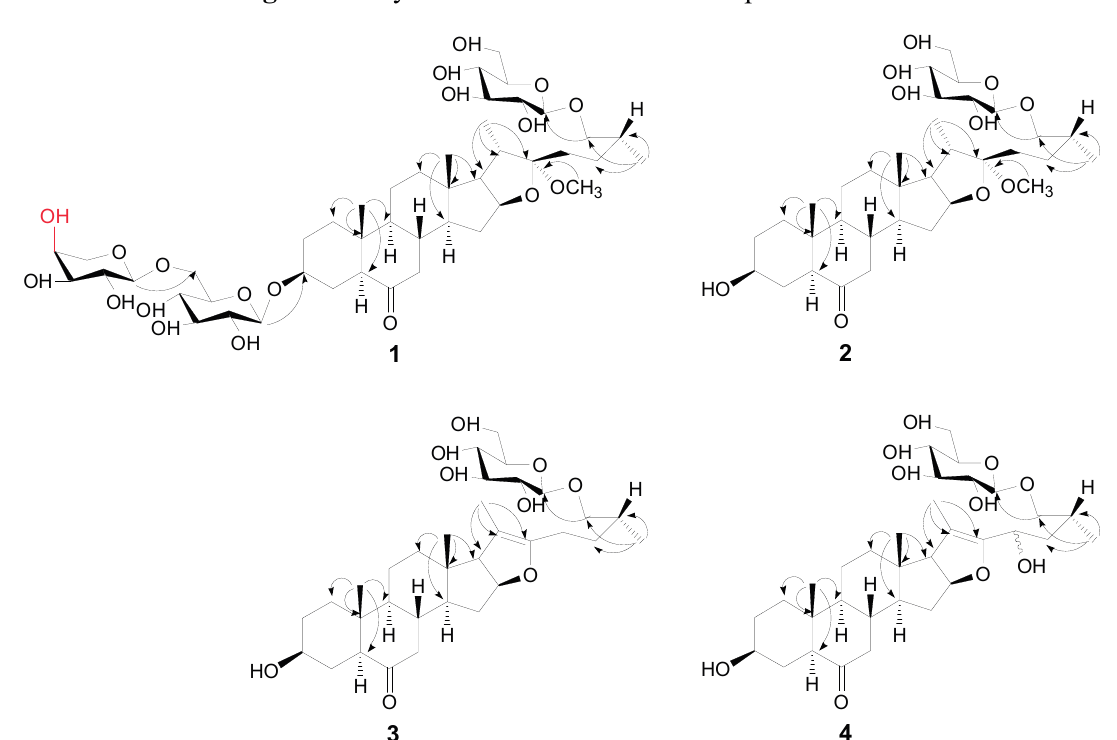
Figure 2. Key HMBC correlations of compounds 1 – 4